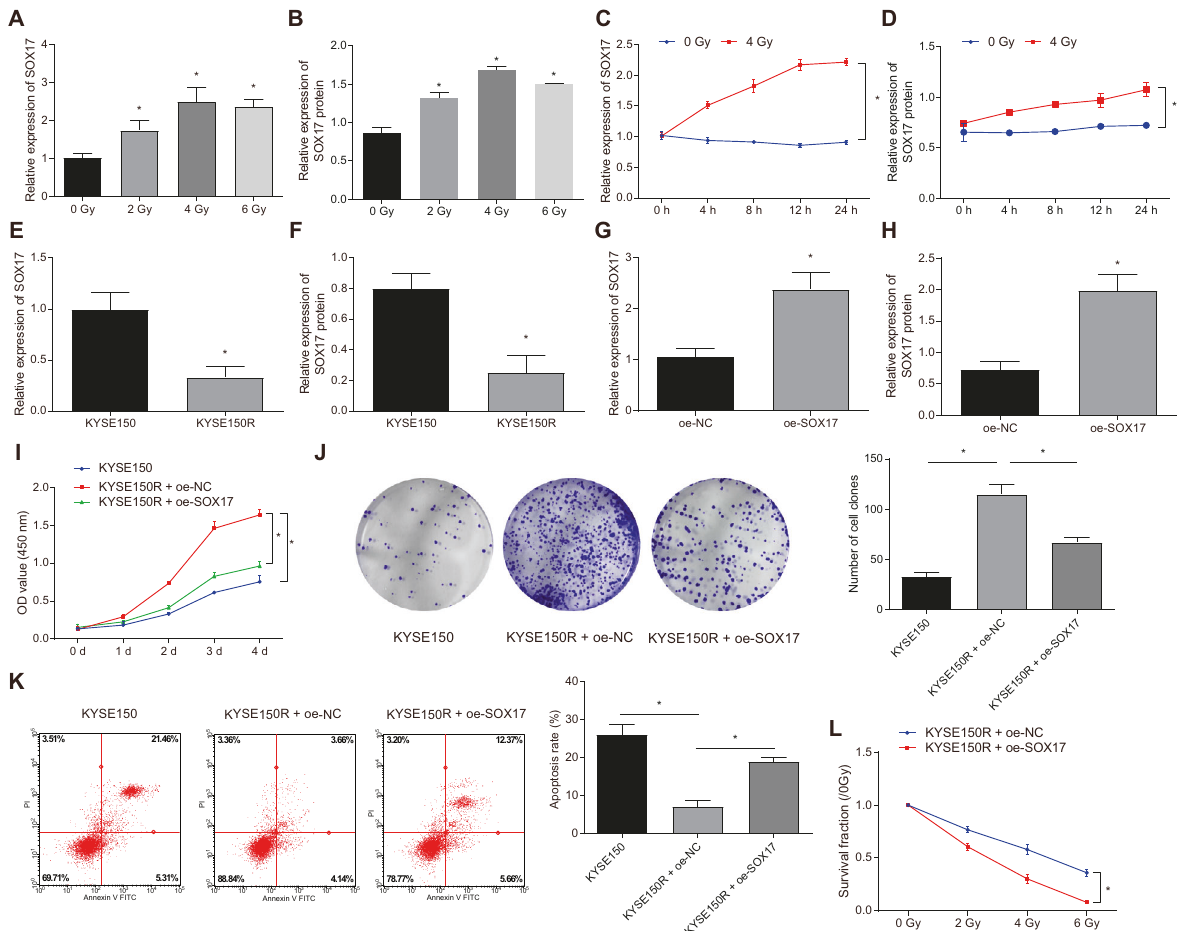
Fig. 2 High expression of SOX17 could decrease the irradiation tolerance of ESCC cells. After treatment with different doses of X-ray, the mRNA and protein expression of SOX17 in KYSE150 cells was measured by qRT-PCR ( A ) and Western blot ( B ). * p < 0.05 compared with 0 Gy group. After exposure to a single dose of X-ray, the expression of SOX17 mRNA and protein in KYSE150 cells was examined by qRT-PCR ( C ) and Western blot ( D ). The expression of SOX17 mRNA and protein was measured by qRT-PCR ( E ) and Western blot ( F ) in KYSE150 cell line and its corresponding irradiation-resistant cell line KYSE150R. G-H, the mRNA and protein expression of SOX17 examined by qRT-PCR ( G ) and Western blot ( H ) in KYSE150R cells in response to oe-SOX17. I, Survival rates of KYSE150R cells in response to oe-SOX17 measured by MTT assay. J The proliferation ability of KYSE150R cells in response to oe-SOX17 examined by clonogenic assay K Flow cytometry was employed to evaluate the apoptosis of KYSE150R cells in response to oe-SOX17. L Clonogenic assay was adopted to measure the proliferation ability of KYSE150R cells in response to oe-SOX17. * p < 0.05. Measurement data were expressed as mean ± standard deviation. Data between two groups were analyzed by unpaired t test. Comparisons between multiple groups were performed by one-way ANOVA, followed by Tukey ’ s post-hoc test. Two-way ANOVA with Bonferroni post-hoc test was employed to compare the data of groups at different time points. Cell experiments were repeated in